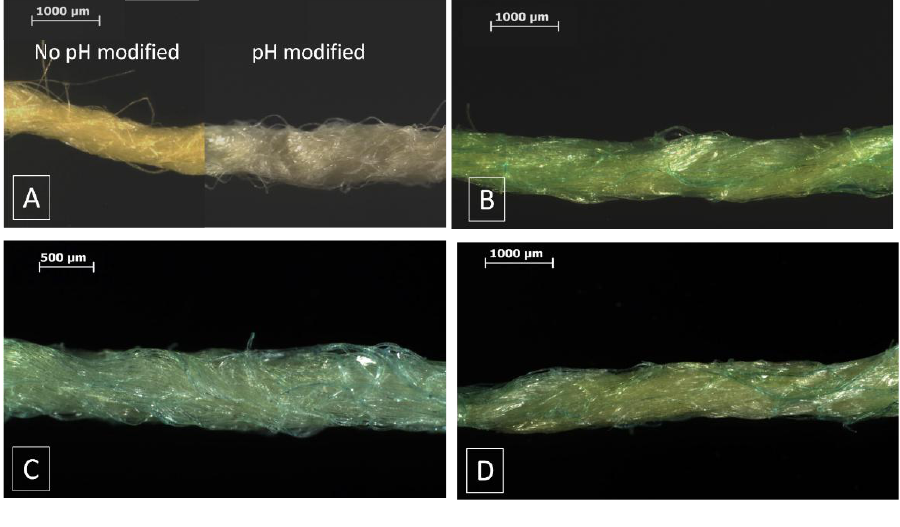
PEC-coated fibers; ( B ) GG int °CH, ( C ) GG int °CH(pH) and ( D ) GG(pH) int °CH(pH). Those PEC-coated fibers are covered with a green colour on the outer layer and yellow colour at core of each